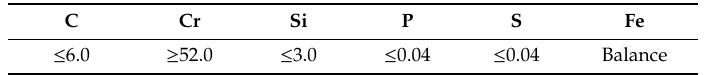
Table 2. Chemical compositions of high carbon ferrochrome powder